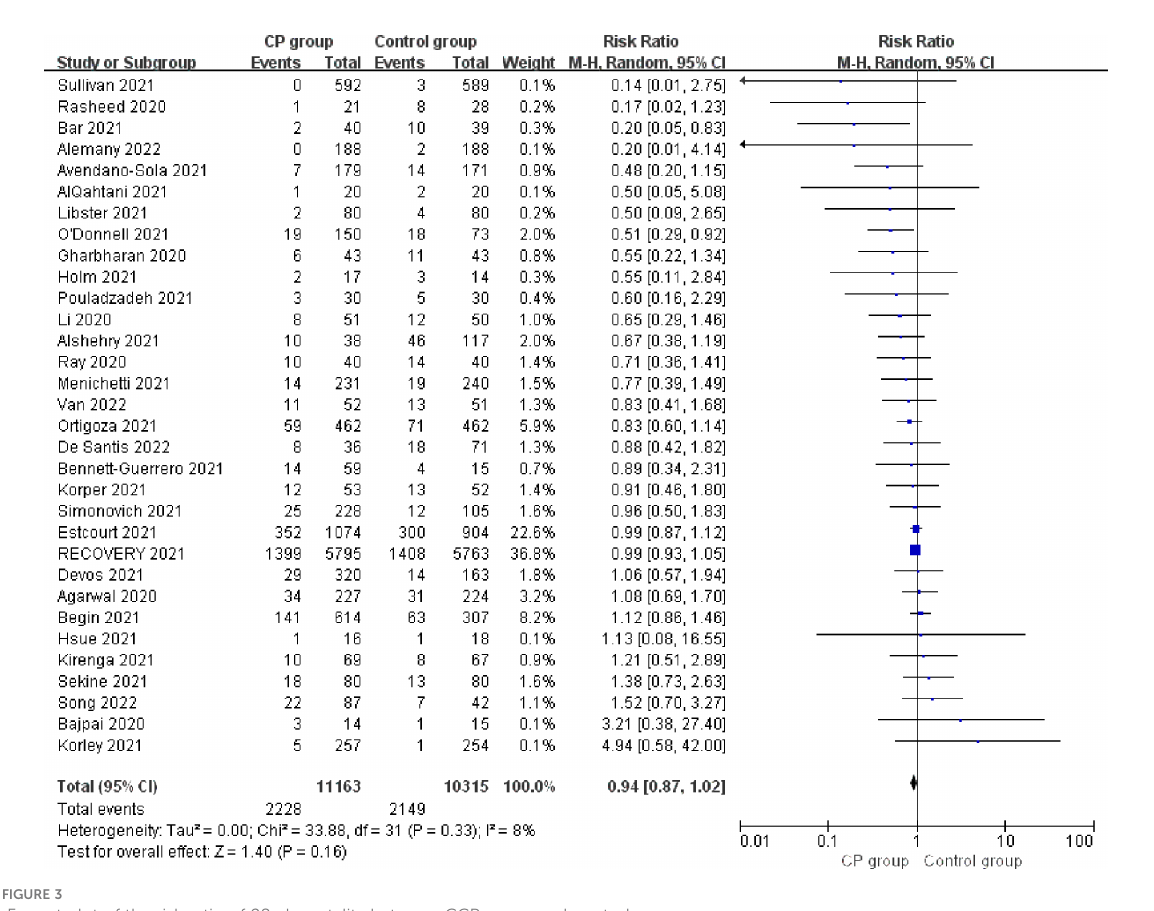
FIGURE 3 Forrest plot of the risk ratio of 28-d mortality between CCP group and control